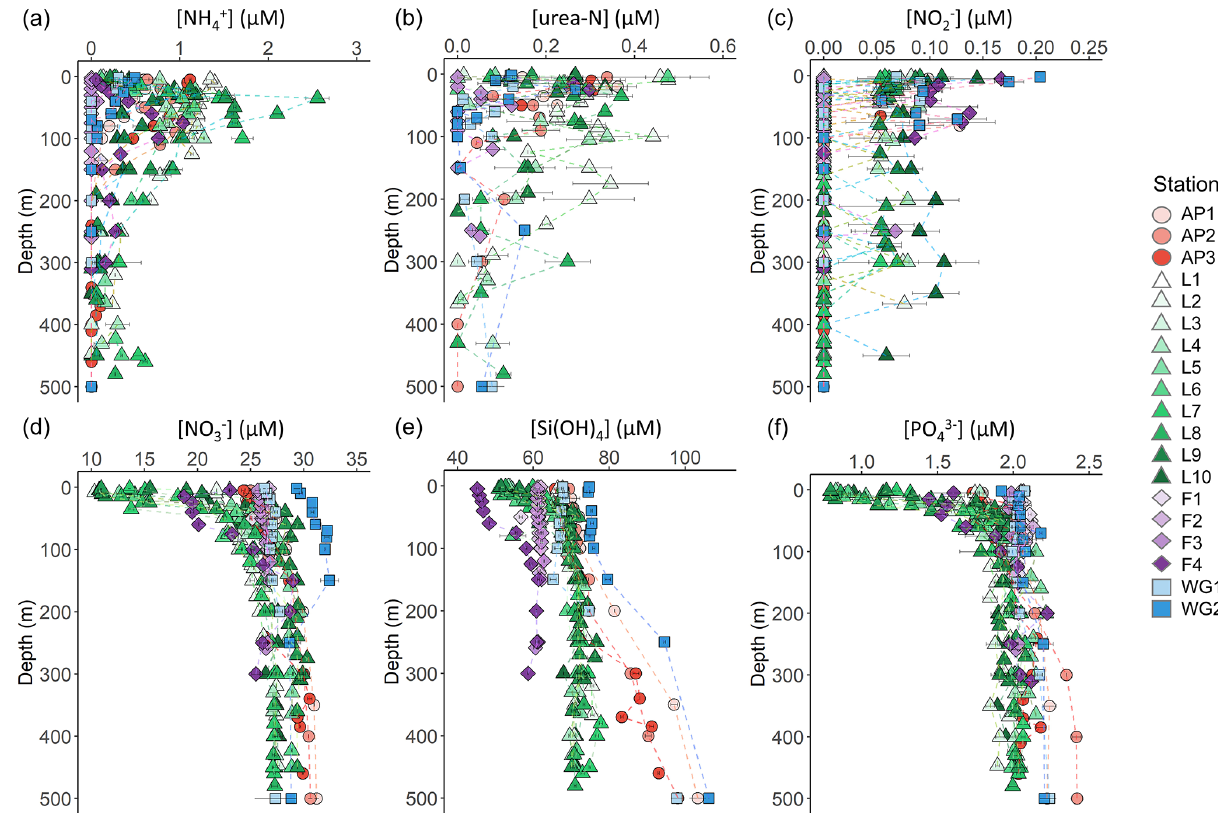
Figure 3. Depth profiles (0–500m) of (a) NH 4 + , (b) urea-N, (c) NO 2 − , (d) NO 3 − , (e) Si ( OH ) 4 , and (f) PO 43 − concentrations. For all panels, the error bars represent ± 1 SD of replicate samples ( n = [ 2 , 3 ] ). For NO 3 − , which was calculated as NO 3 − + NO 2 − − NO 2 − , error has been propagated according to standard statistical practices. Note that the x -axis scales in panels (d–f) do not start at